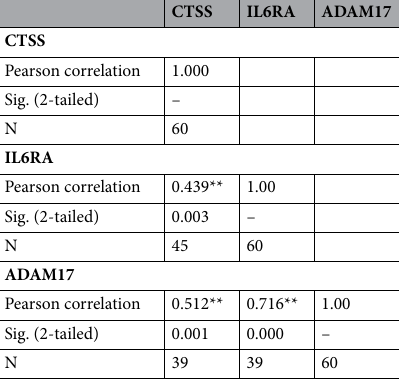
Table 1. Matrix of correlations. **Correlation is significant at the 0.01 level